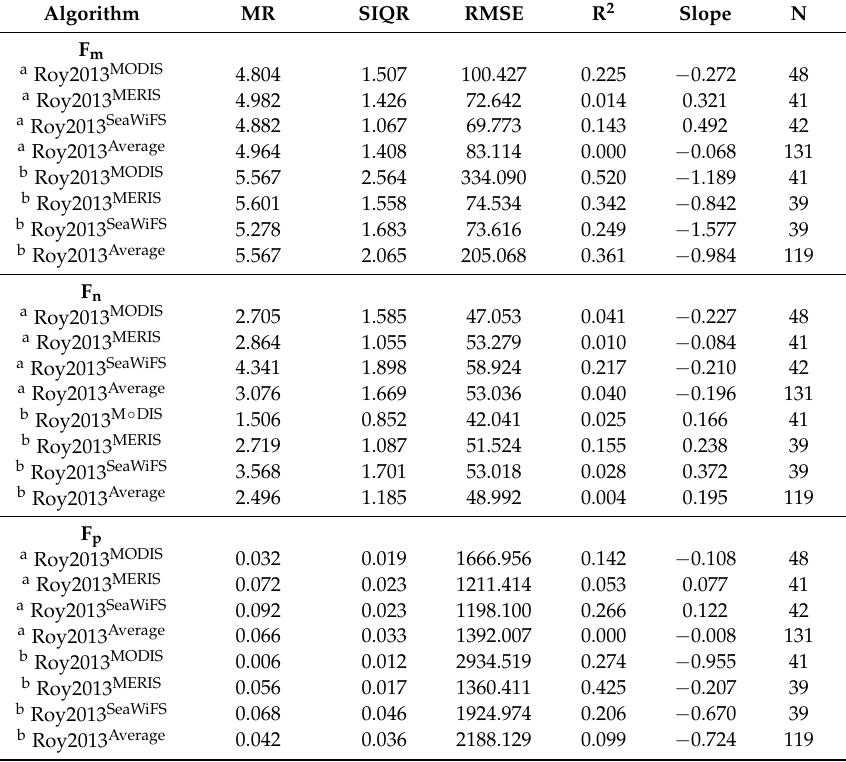
Table 6. Statistical results for the validation of the inherent optical property (IOP)-based algorithm for MERIS, MODIS and SeaWiFS. The slope is the linear regression results from retrievals versus in situ ones. N is the number of